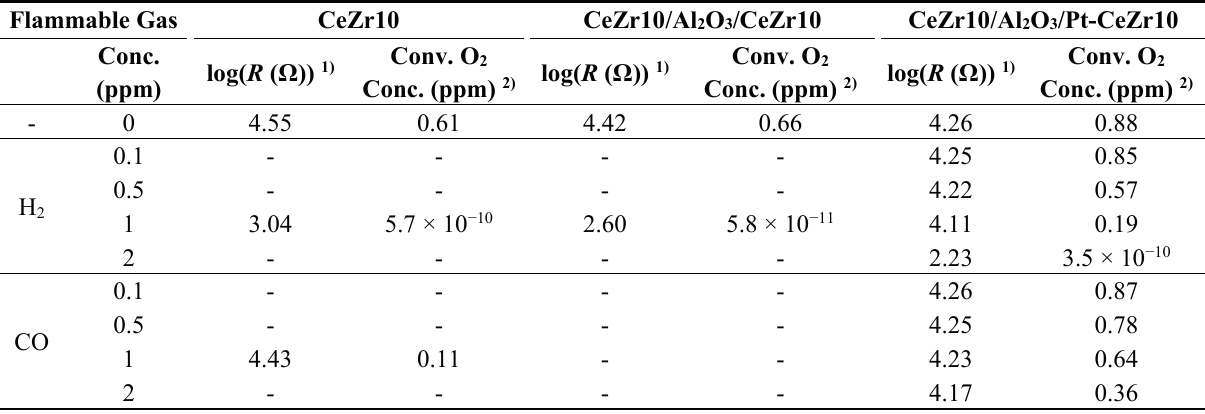
Table 1. Resistances and converted oxygen concentrations of thick film sensors in ~1 ppm oxygen, in the presence and absence of flammable gases. Flammable Gas CeZr10